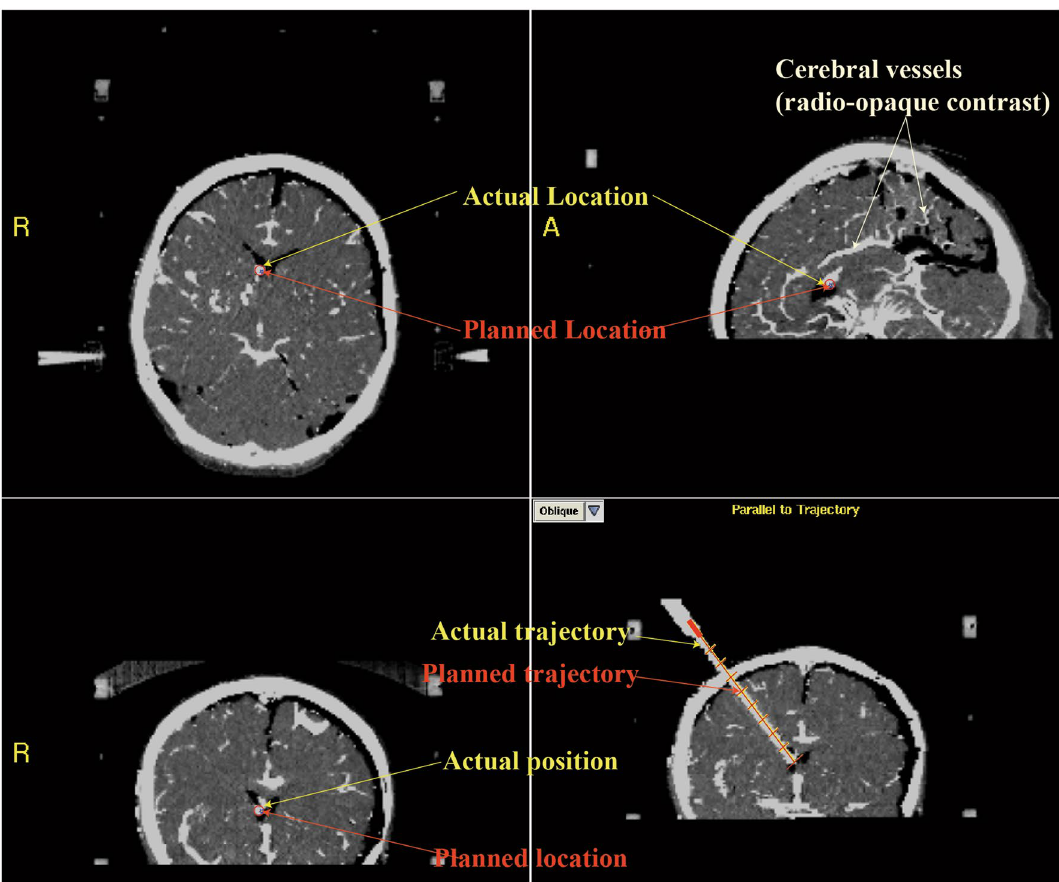
Figure 4. CT images showing robust targeting accuracy in a representative pre-clinical experiment (COMPASS software). The actual location of catheter tip (red circle) is seen to be overlying the planned location (blue dot). The bottom right panel shows the actual catheter trajectory (white glow) with superimposed planned trajectory (red line). Cerebral vasculature was avoided while placing the